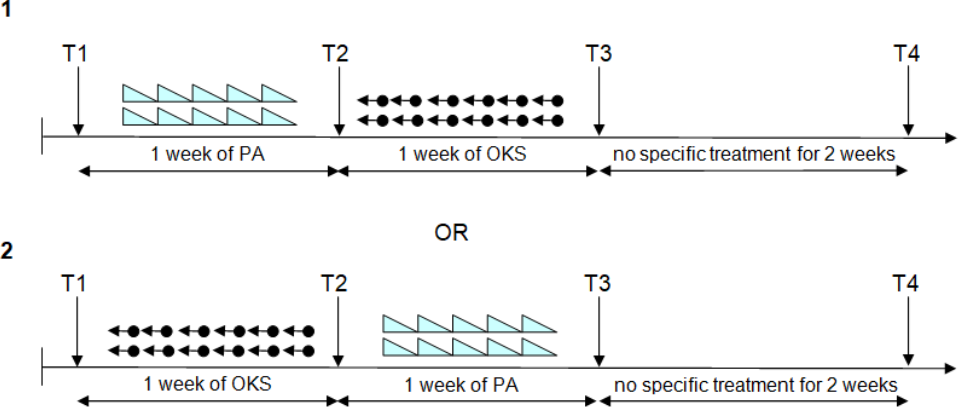
Figure 2. Schematic of the procedure. The two procedures of training, PA and OKS, were applied using a crossover design. T1 : first evaluation before the first training block; T2 : second evaluation between the first and second training blocks; T3 : third evaluation after the second training block; T4 : follow-up evaluation after two weeks without specific treatment.